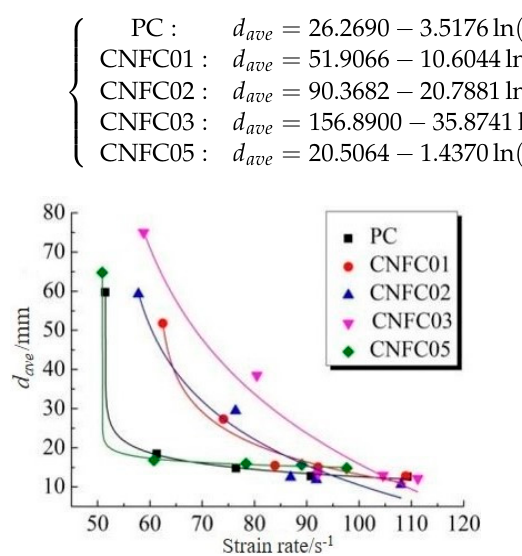
Figure 11. Relationship between d ave and strain rate.